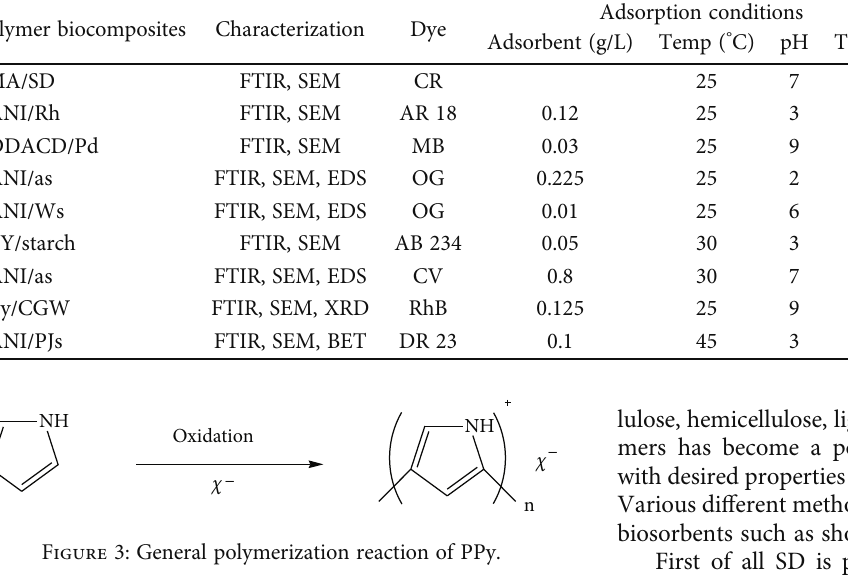
Table 3: List of polymer/agro waste-based biocomposites used for dyes adsorption. Polymer biocomposites